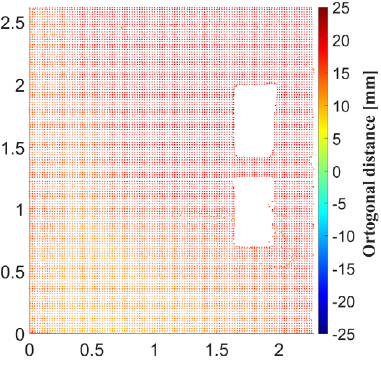
Figure 18. Deviation map, the wall no. 8—comparison of the IFC plane and the segmented point cloud.